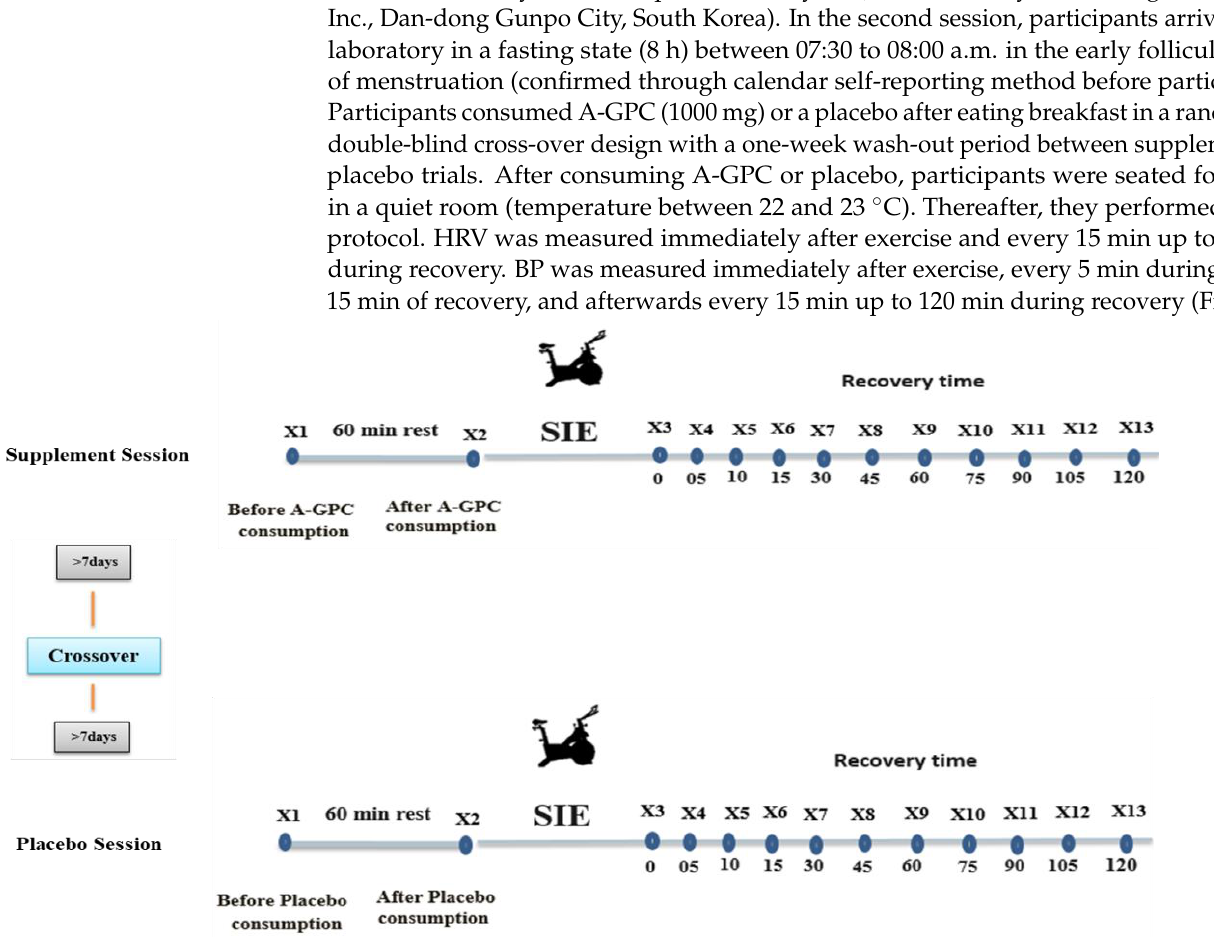
Figure 1. Research design (X = Measurement).